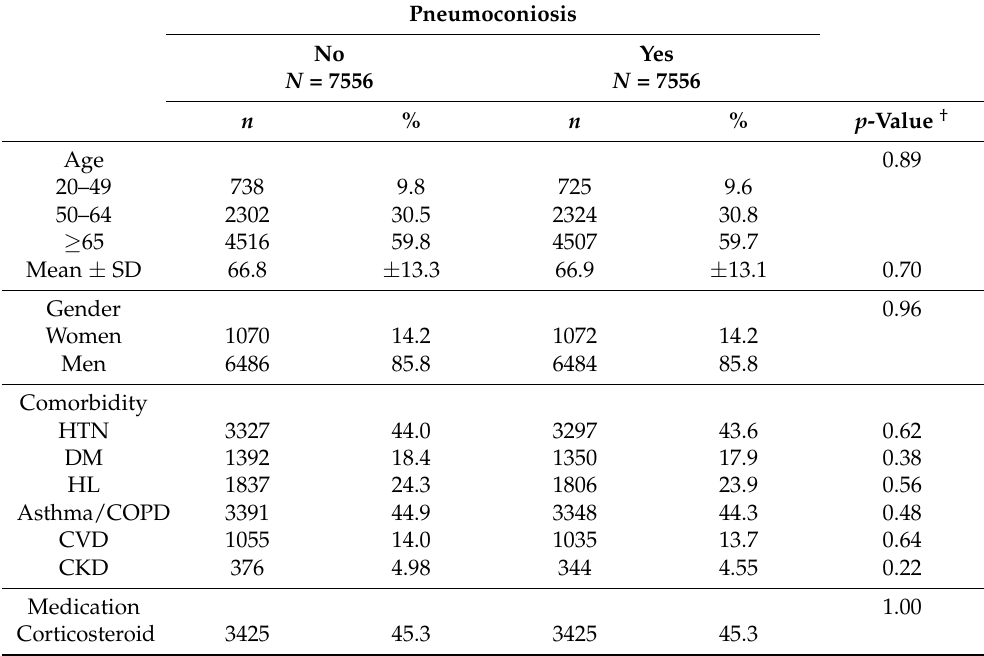
Table 1. Baseline characteristics in the study